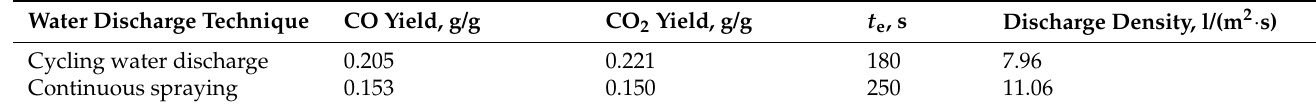
Table 6. Yields of pyrolysis and combustion products of timber when spraying water using different techniques.